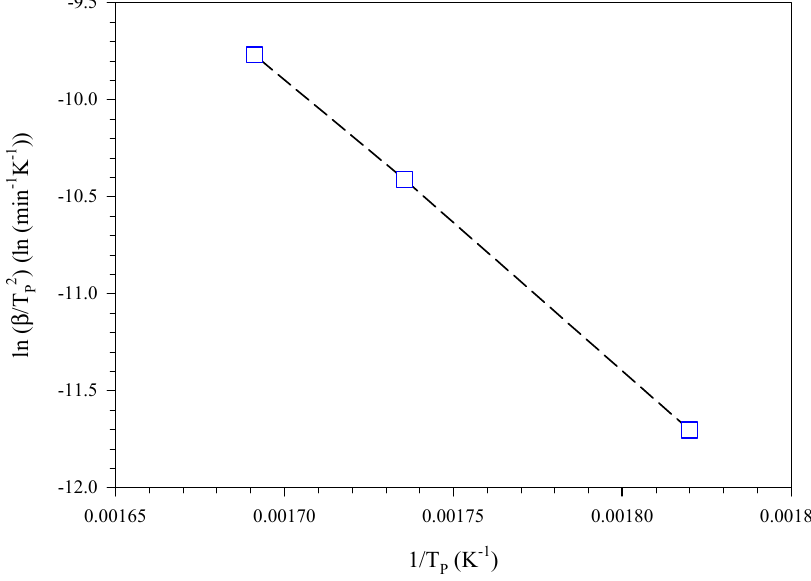
Figure 3. Kissinger plot corresponding to the curves of Figure